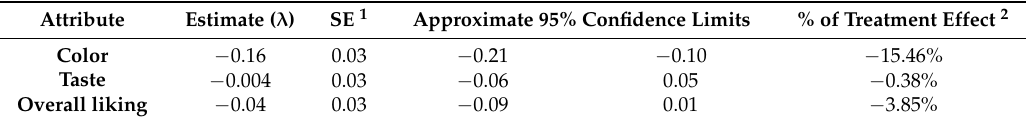
Table 7. Estimates of the proportionality parameter ( λ ) for the carryover effects on three attributes (color, taste, overall liking) from model